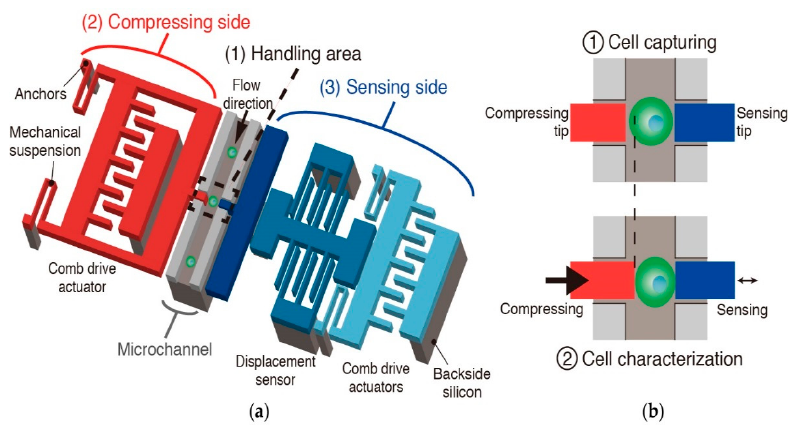
Figure 1. ( a ) Schematic image of the device with embedded channel, ( b ) A close-up view of the tips at the handling area.